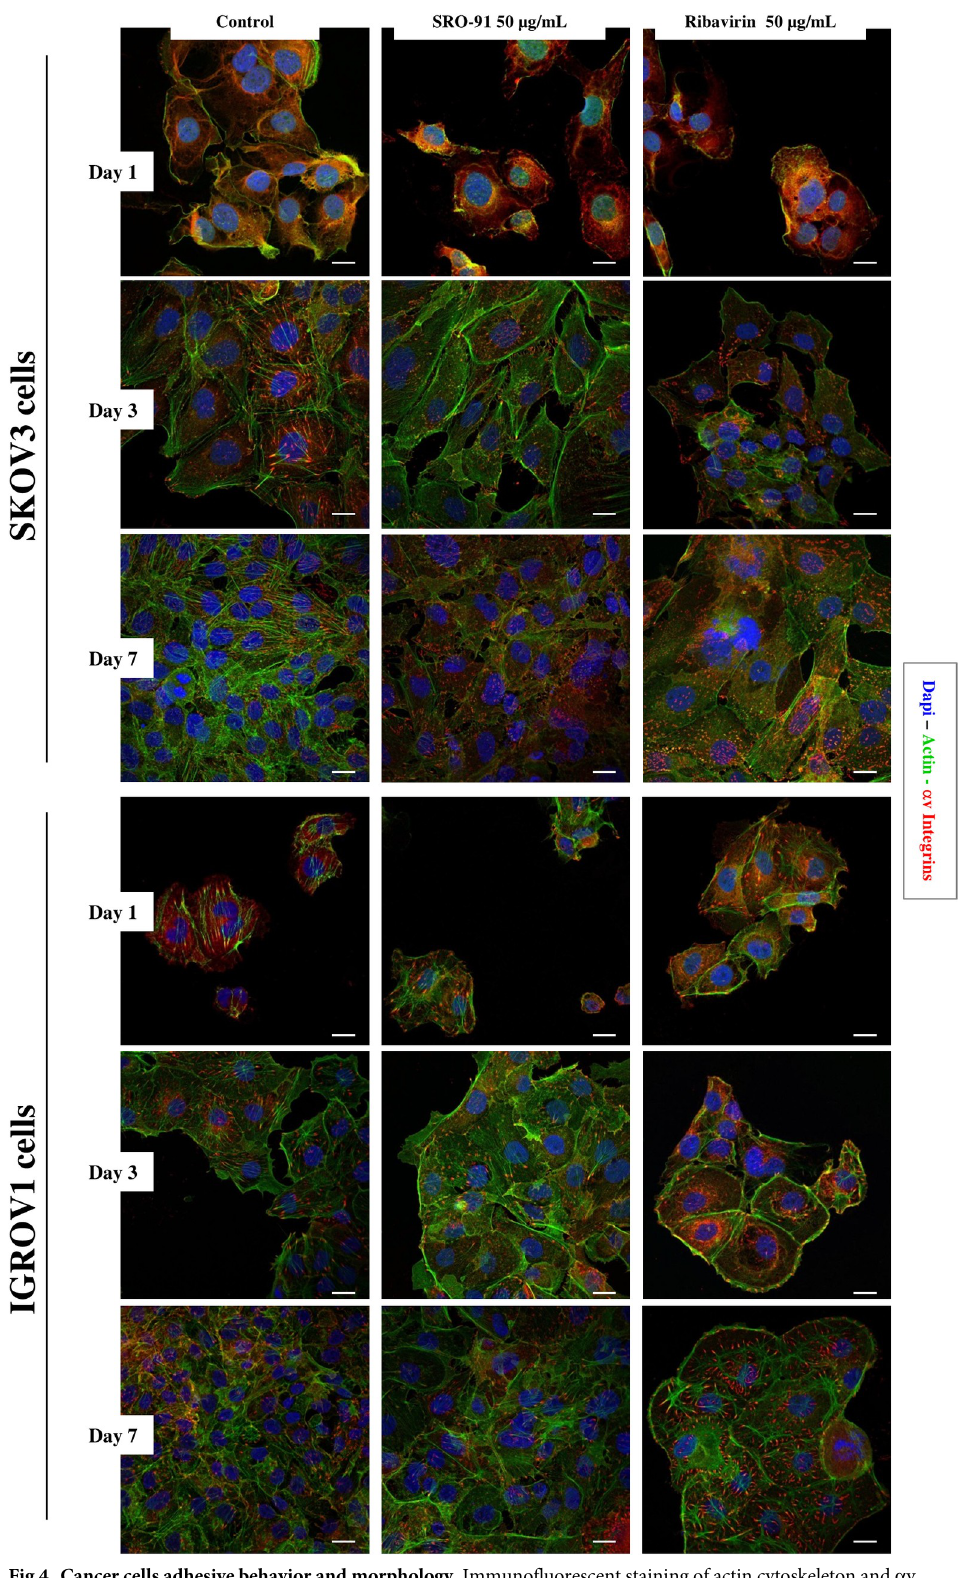
Fig 4. Cancer cells adhesive behavior and morphology. Immunofluorescent staining of actin cytoskeleton and α v integrins expressed by cancer SKOV3 and IGROV1 cells after SRO-91 or ribavirin treatment or without treatment (control). Cell nuclei were stained with DAPI. Staining was examined with laser scanning confocal microscopy. Scale bar is 30 μ m.